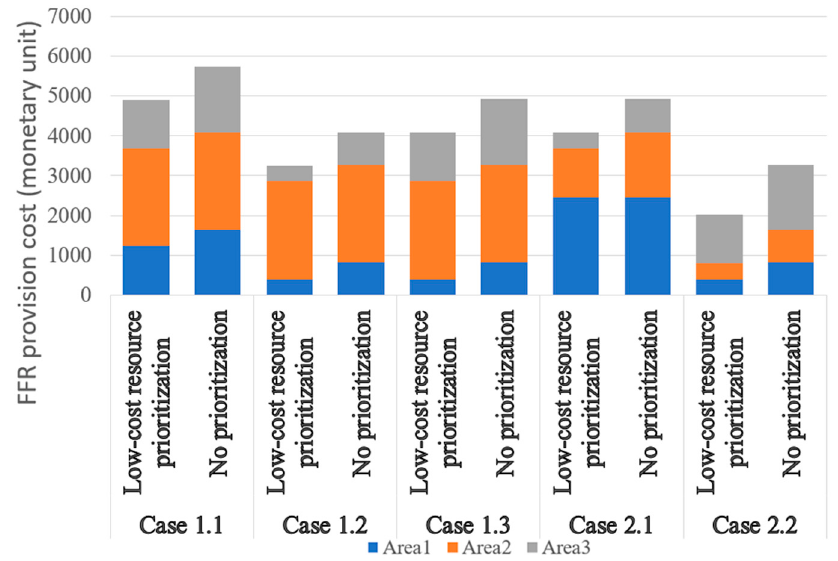
Figure 19. Provision costs of FFR